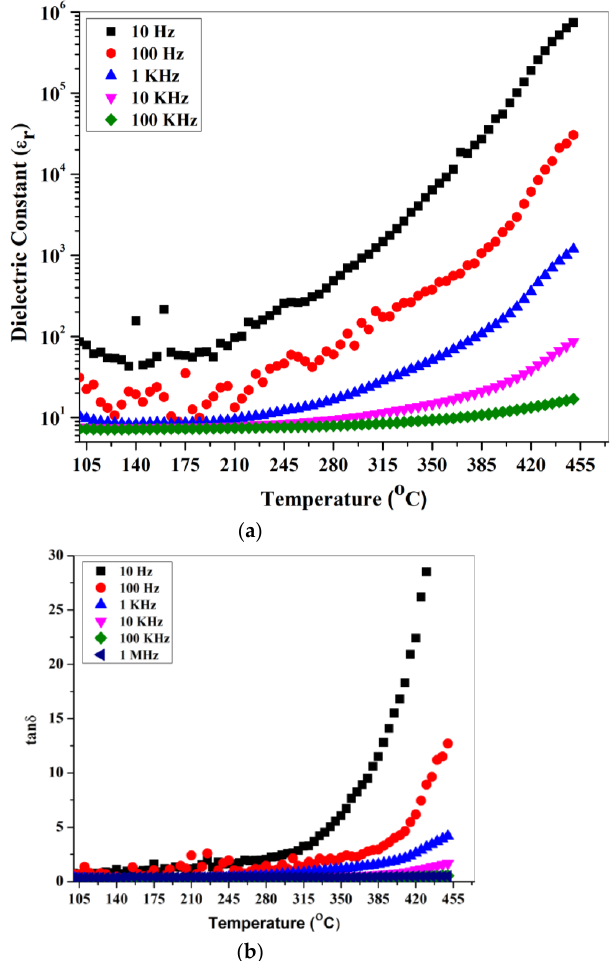
Figure 7. Temperature-dependent ( a ), dielectric permittivity and ( b ) dielectric loss of bulk gahnite ferroan composite, carried out at different frequencies.